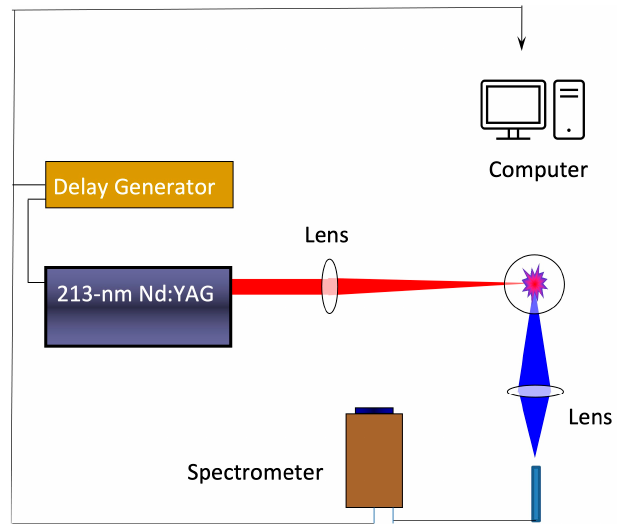
Figure 1. Depiction of the LIBS system used in this